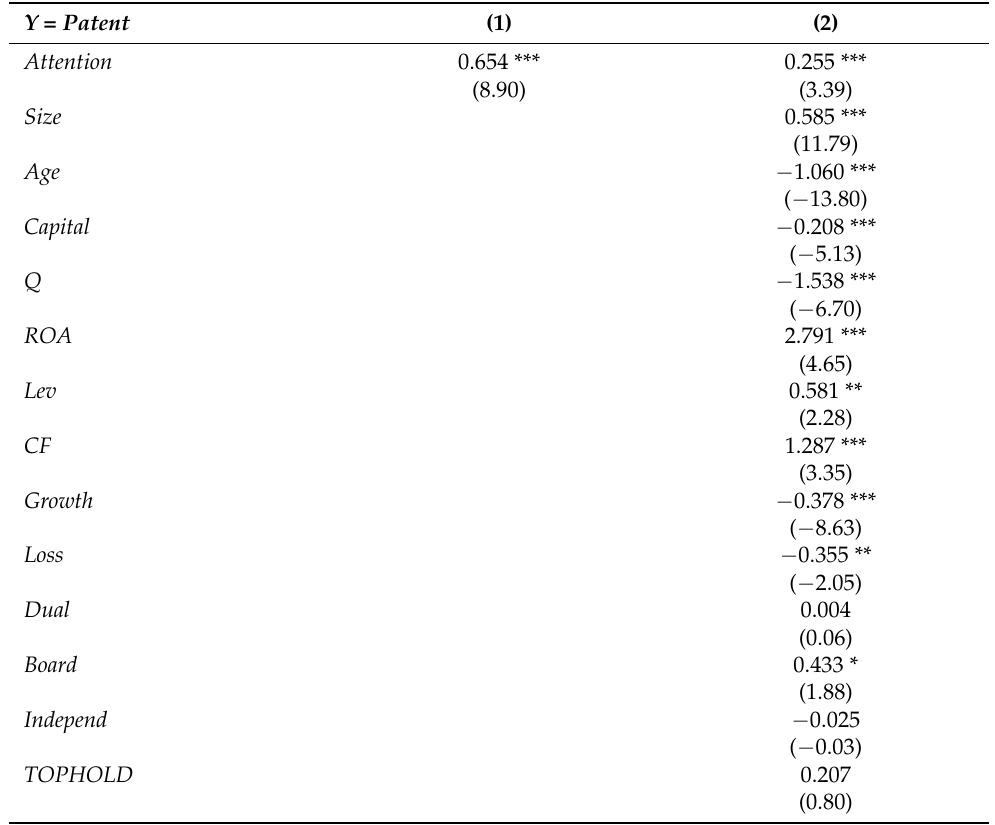
Table 3. The impact of investor attention on corporate